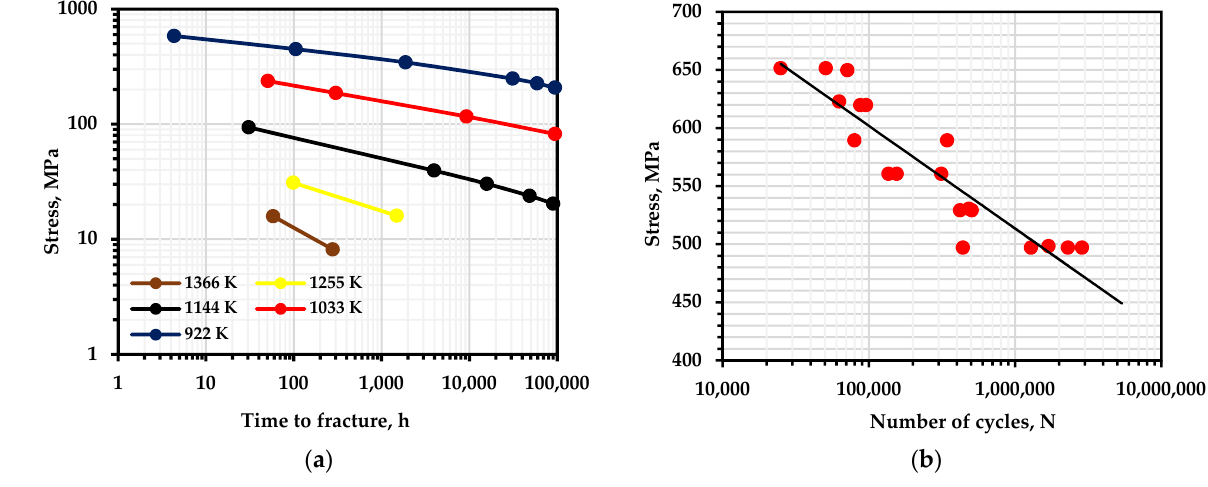
Figure 1. Durability curves: ( a )—creep [44]; ( b )—fatigue at 300 K [45] for nickel alloy 625+. Extrapolating the U ( σ ) axis at the point σ = 0, we obtain the value of the stable parameter U 0 , which is stable with respect to the structure (Figure 2a).